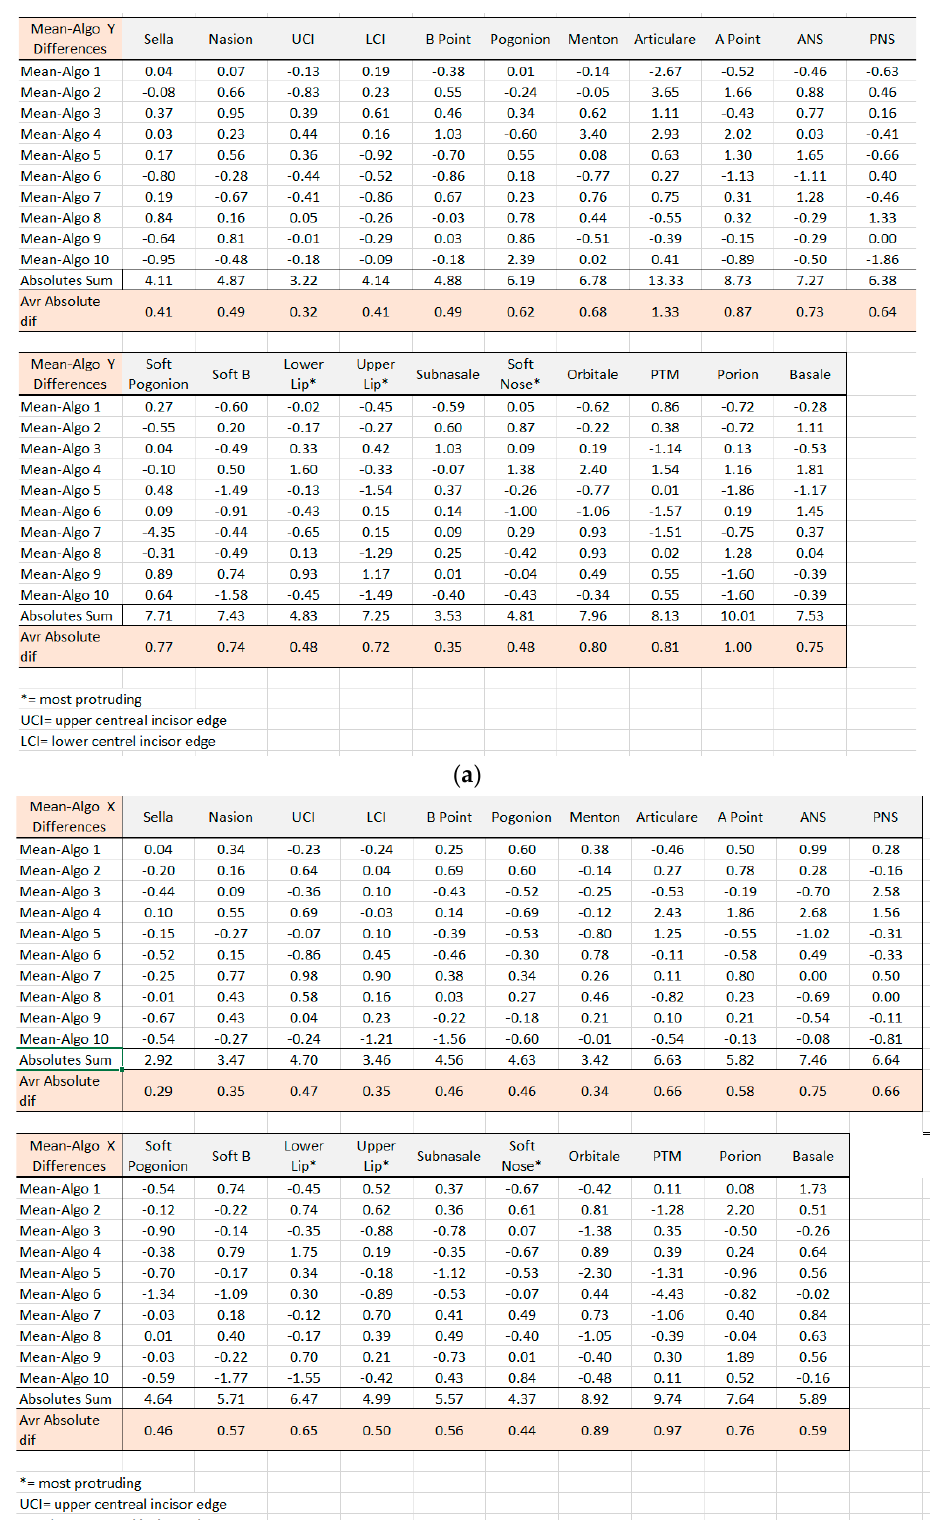
Figure 5. Correlation between general AI and observer scores.